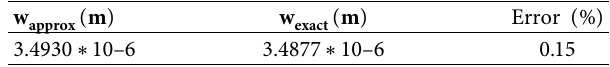
Table 7: Deflection of S-S beam (1), ( F � 30 N). ( m ) w w approx